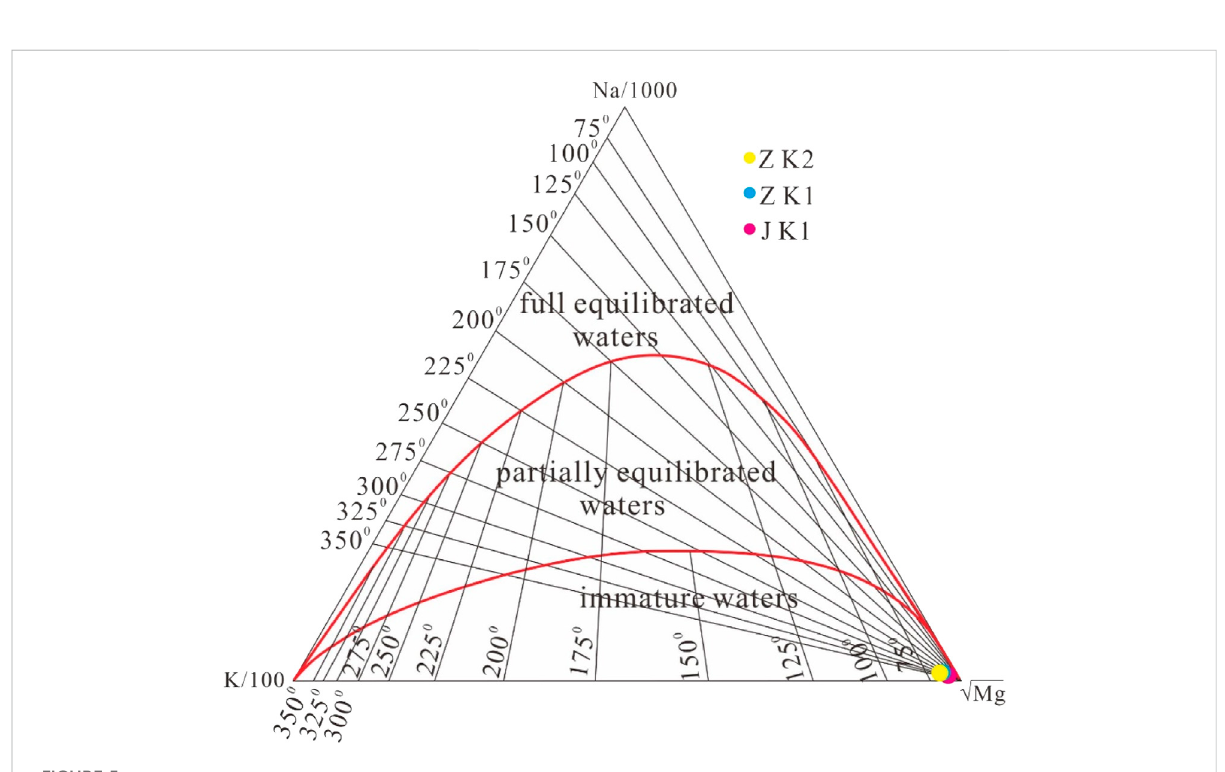
FIGURE 5 Triangular diagram for